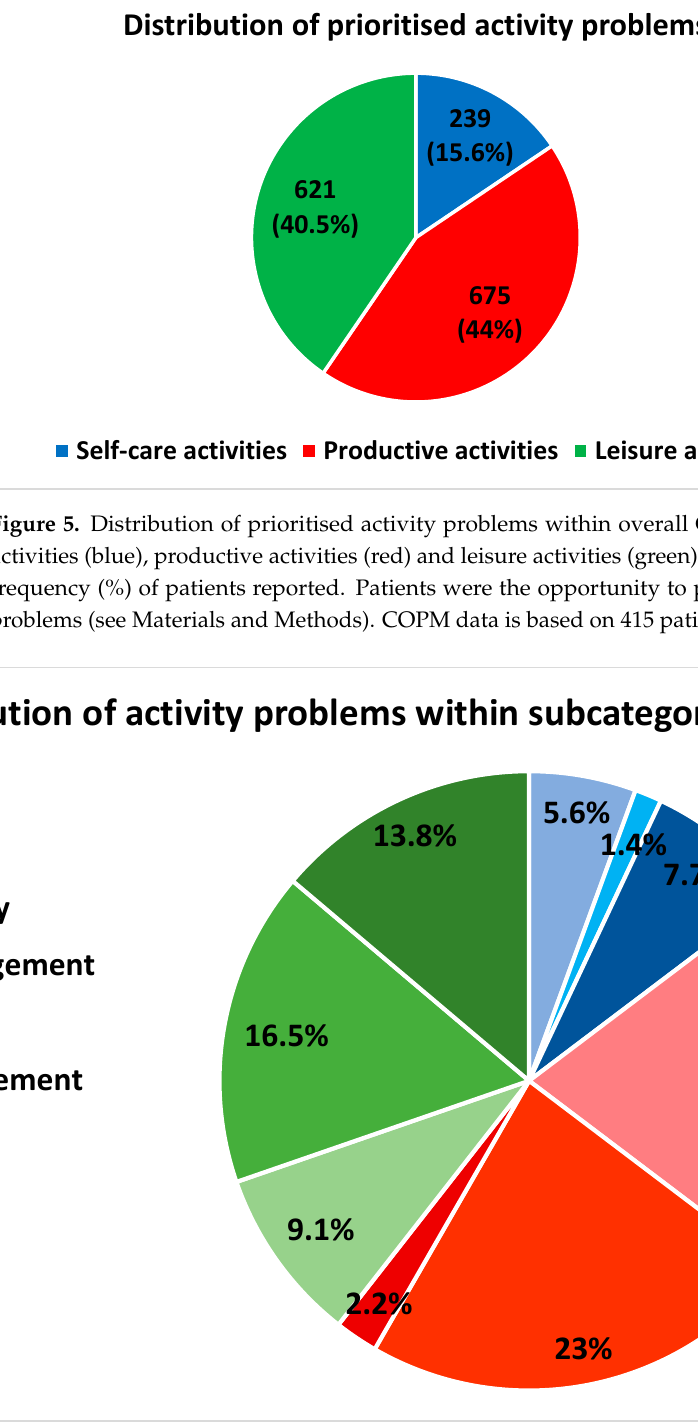
Figure 6. Distribution of activity problems (%) within the COPM subcategories: self-care (blue) comprising personal care, functional mobility and community management; productive activities (red) comprising paid/unpaid work, household management and play/school; leisure activities (green) comprising quiet recreation, active recreation and socialisation. COPM data is based on 430 patients.